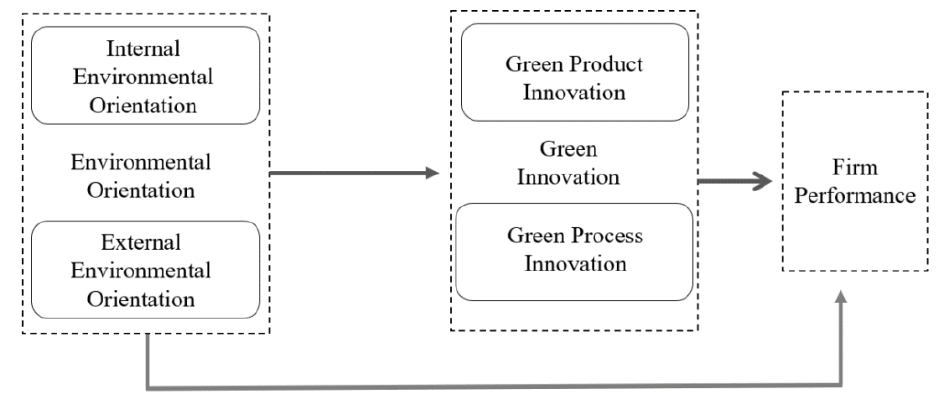
Figure 1: Proposed conceptual